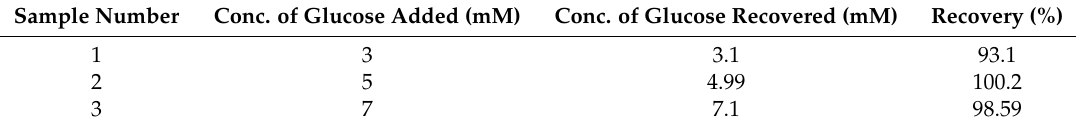
The determination of glucose concentrations in blood serum samples using a CuO-modified